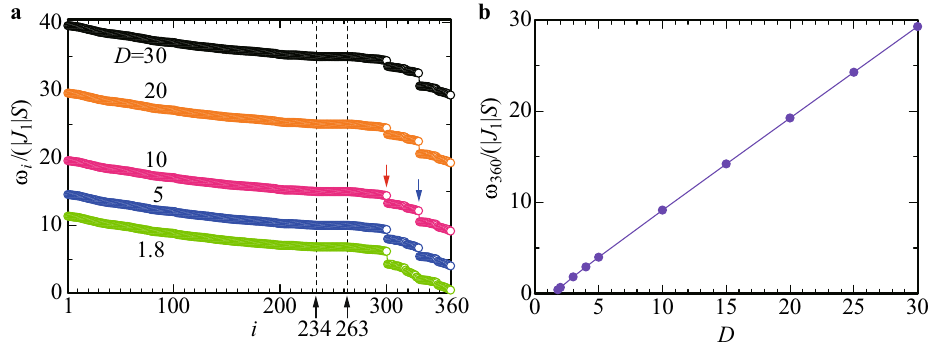
1.8, 5, 10, 20 , and 30. The dashed lines indicate 1 and J 2 1 with D Figure 2. ( a ) ω i vs i for J 1 = = − = − 234 and i 263 . Red arrow points to i 300 and blue arrow points to i i = = = dependence of the lowest excitation energy ω 360